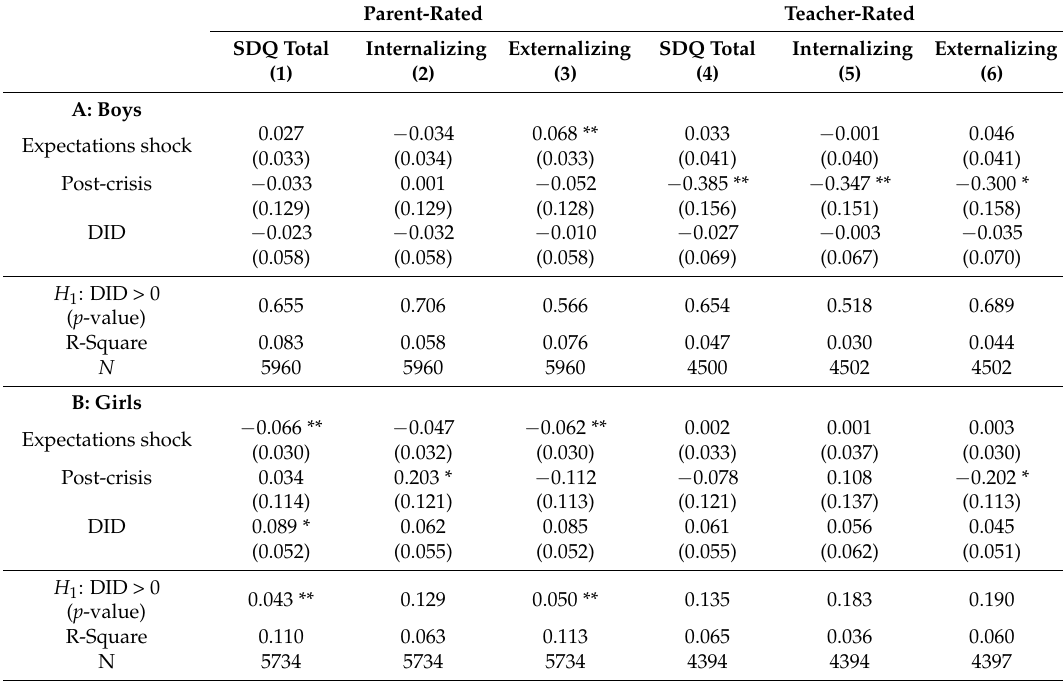
Table 3. The effects of less intense unemployment expectations shocks (greater than average) on parent- and teacher-rated SDQ outcomes, separately for boys and